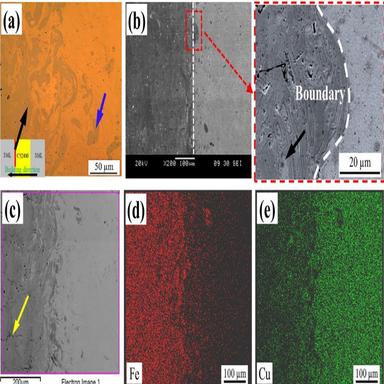
Microstructure, morphology and chemical element distribution at C/L interface: (a) Optical image; (b) SEM image; (c) (d) (e) Fe and Cu element distribution at the interface using EDS mapping.